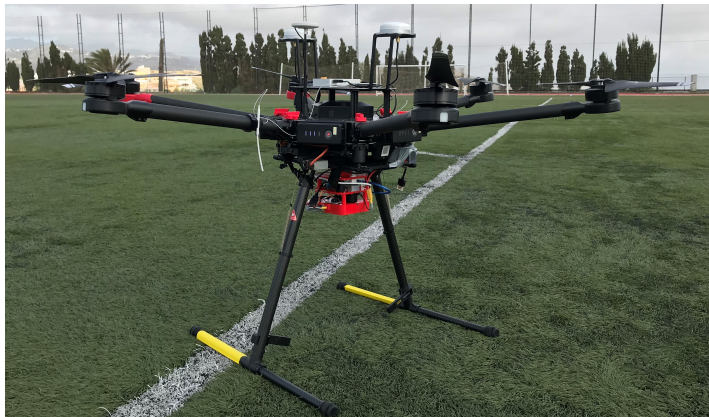
Figure 13. The multispectral camera installed in the Dji Matrice